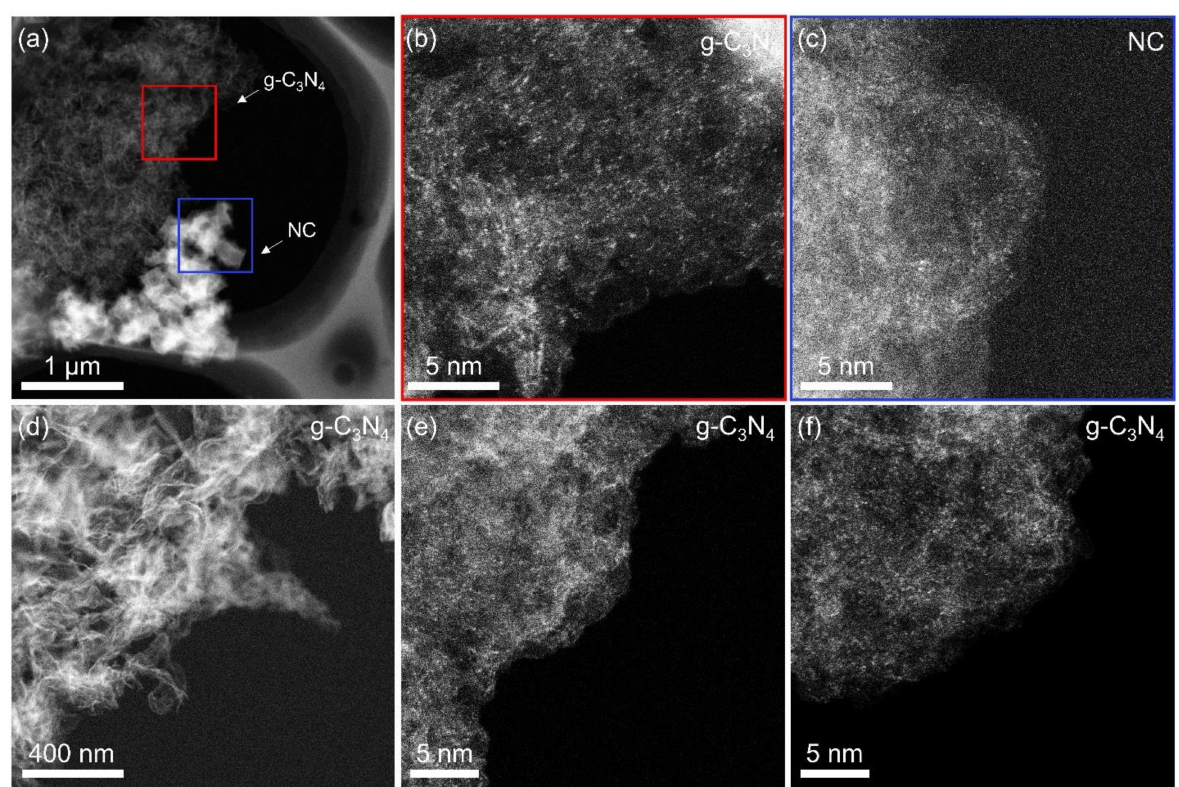
Figure 3. HAADF-STEM images of ( b ) g-C 3 N 4 and ( c ) NC, corresponding to the red and blue areas in ( a ), respectively. ( d – f ) HAADF-STEM images of g-C 3 N 4 , where the region is far away from the region of ( a ).